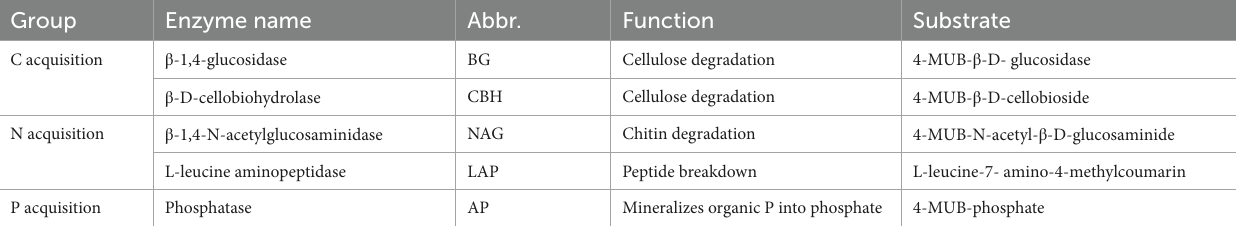
TABLE 1 Names, Abbr. (abbreviations), functions, substrate and groups of soil enzymes that were measured in the current study. Group Enzyme name